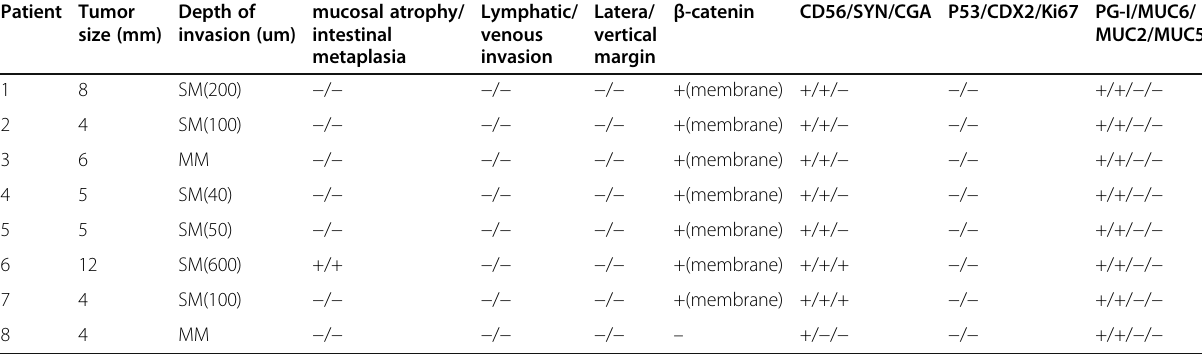
Table 2 Pathological features of present cases Patient Tumor Depth of mucosal atrophy/ size (mm) invasion (um)